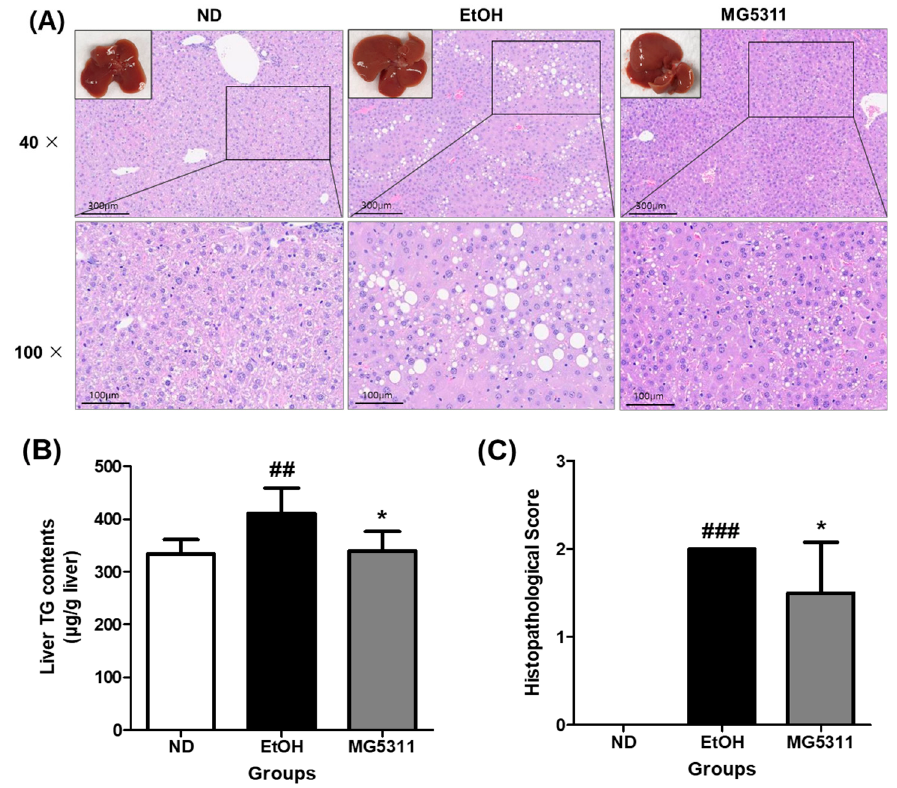
Figure 6. Effect of L. brevis MG5311 on histological changes in liver tissues of ethanol-fed mice. ( A ) representative images of liver tissue and H&E-stained liver tissue (40× and 100× magnification); ( B ) hepatic TG content; and ( C ) histopathological score. Data are presented as mean ± SD ( n = 6). Significance was analyzed by Dunnett’s test. ## p < 0.01, ### p < 0.001 vs. ND group. * p < 0.05 vs. EtOH group. ND, normal diet group; EtOH, ethanol diet group; MG5311, ethanol diet- L. brevis MG5311 administered group.